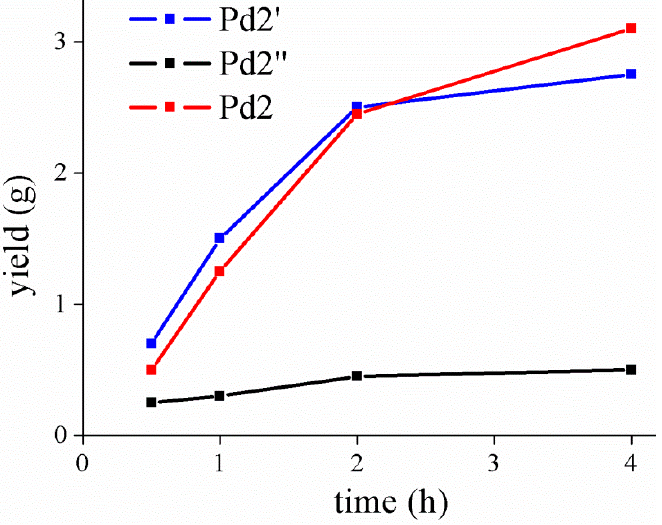
Figure 2. Polyethylene yield versus polymerization time at 80 °C for catalysts Pd2 , Pd2 ′ and Pd2 ″ .